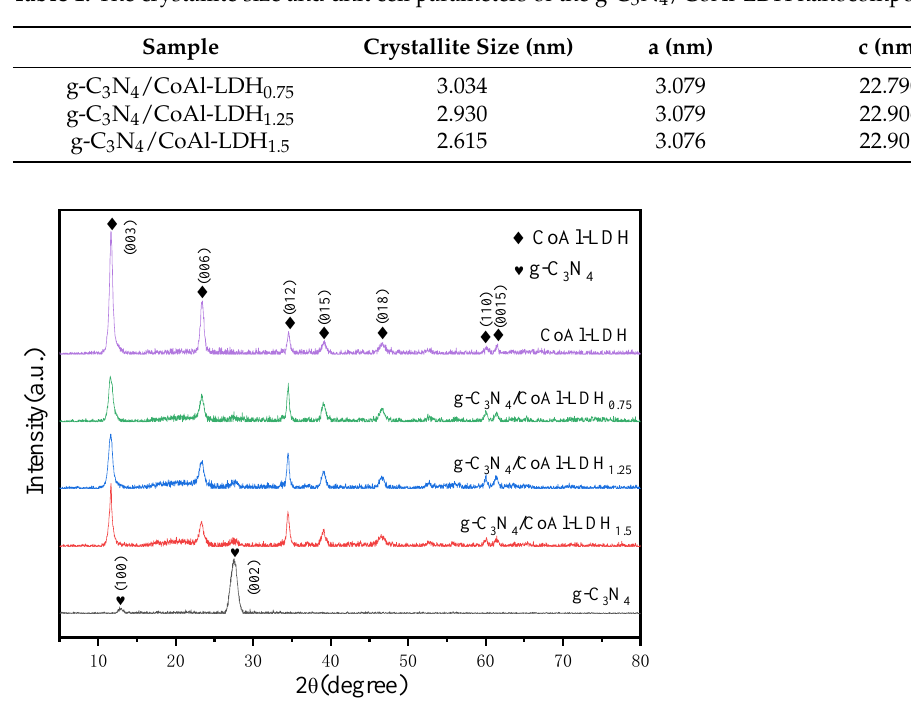
Figure 1. XRD patterns of CoAl-LDH, g-C 3 N 4 , and the g-C 3 N 4 /CoAl-LDH nanocomposites.